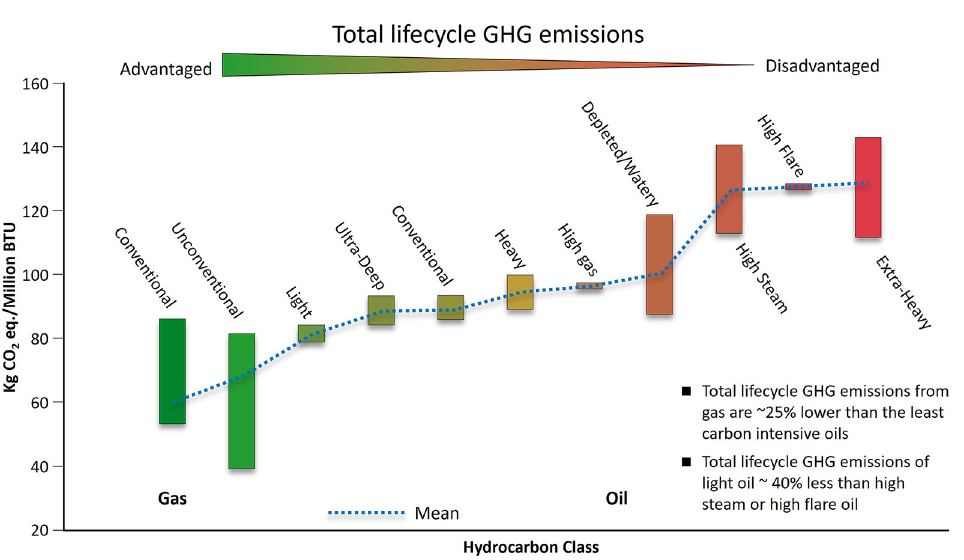
Fig. 7. – Total lifetime GHG emissions for different types of oil and gas resource (Source: Davies and Simmons, 2021